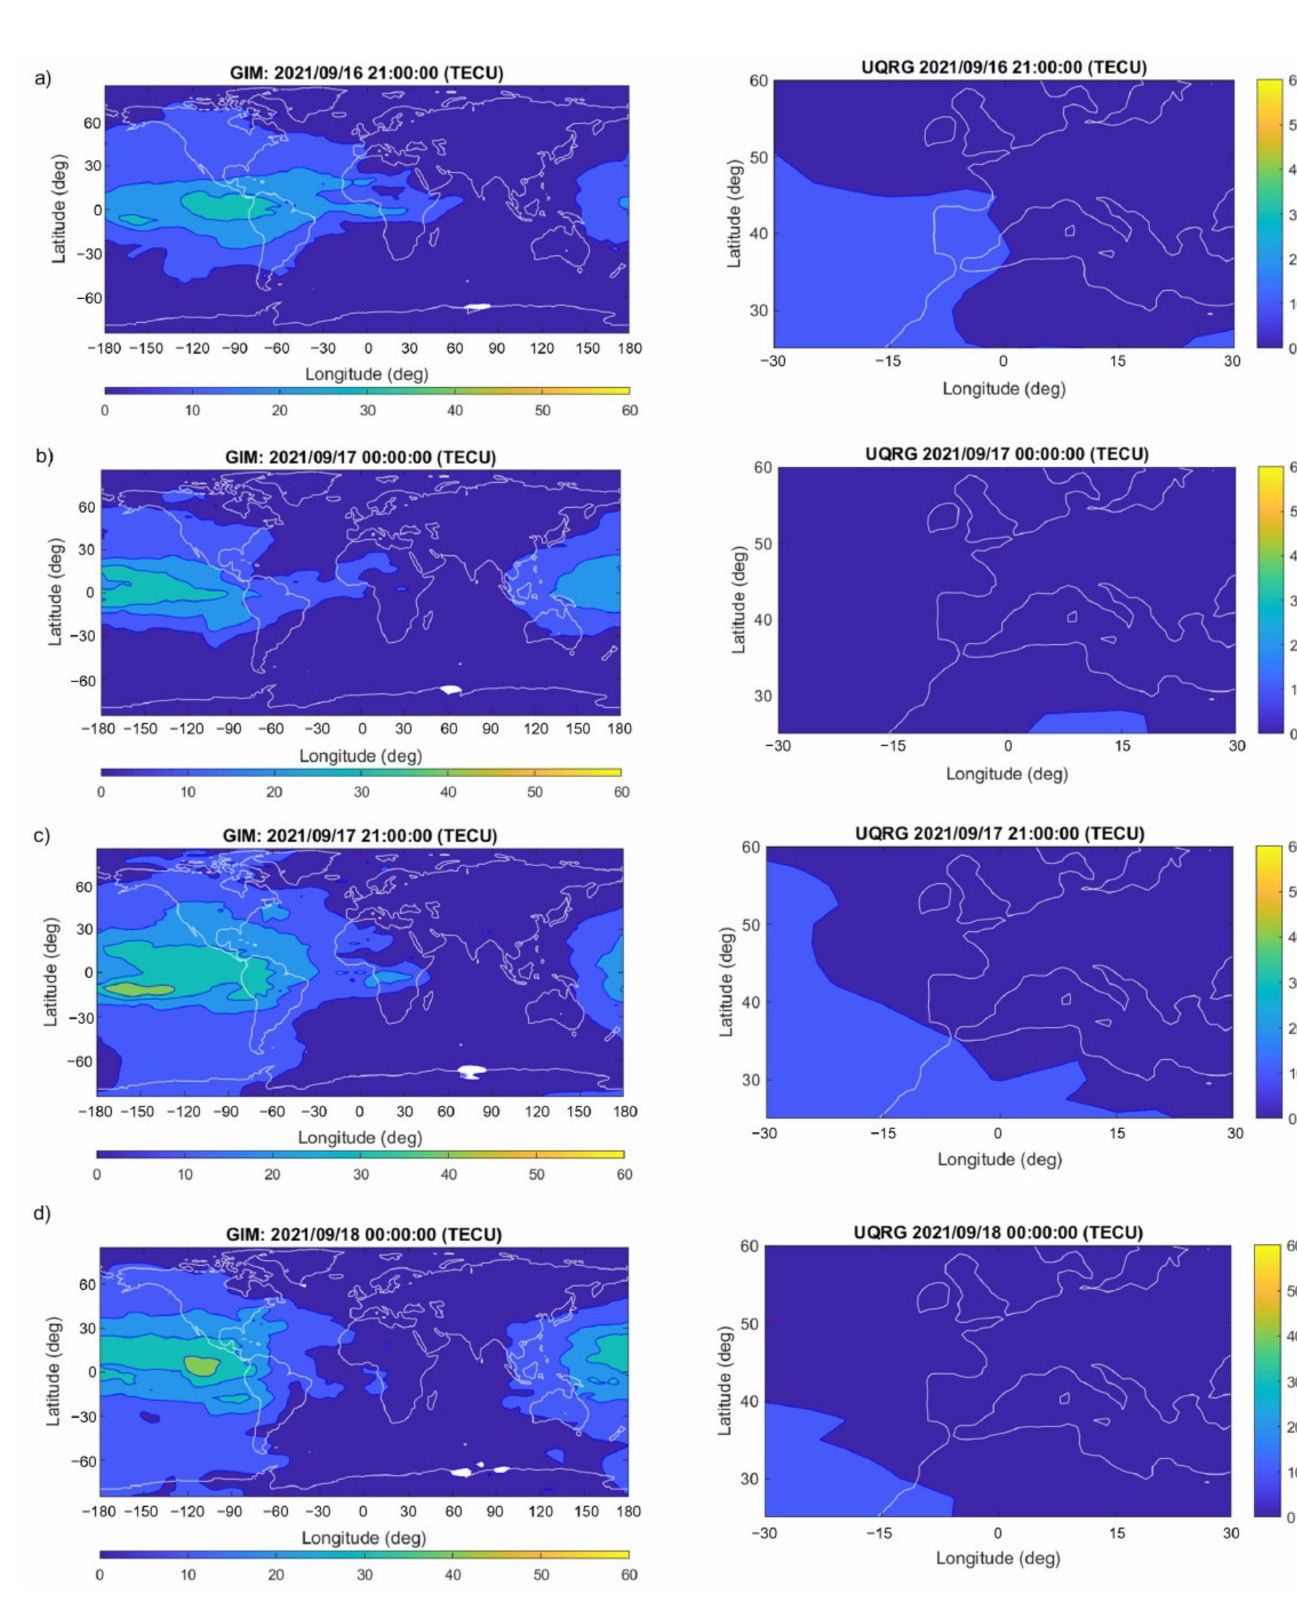
Figure 8. GIMs obtained in ( a , b ) quiet conditions previous to the geomagnetic storm and ( c , d ) in the hours of most disturbed geomagnetic conditions during the main phase (21–00 UT) of the 17–18 September 2021 geomagnetic storm. Colours indicate the values of vTEC in TECU. On the right panels, a zoom of the region of interest (Iberian Peninsula and Western North Africa) is